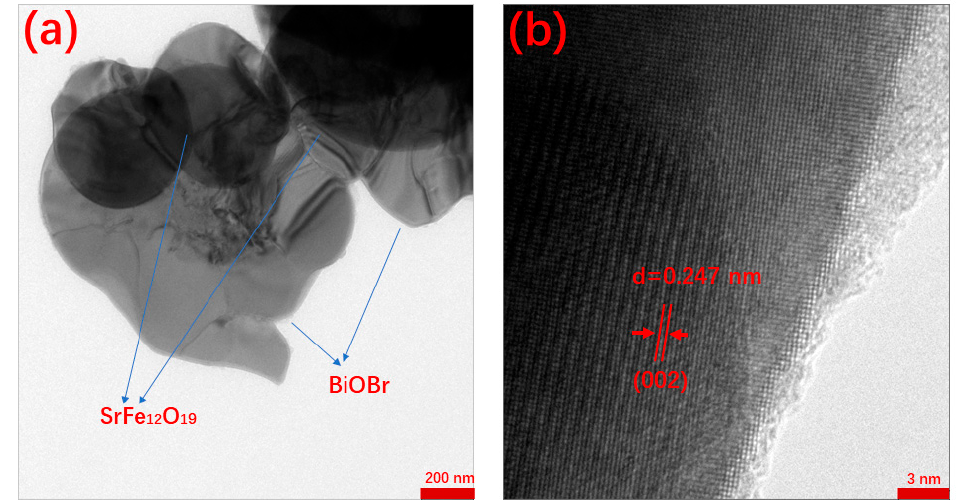
Figure 3. ( a ) Transmission electron microscope (TEM) and ( b ) high-resolution transmission electron microscopy (HR-TEM) of BOB/SFO-5.